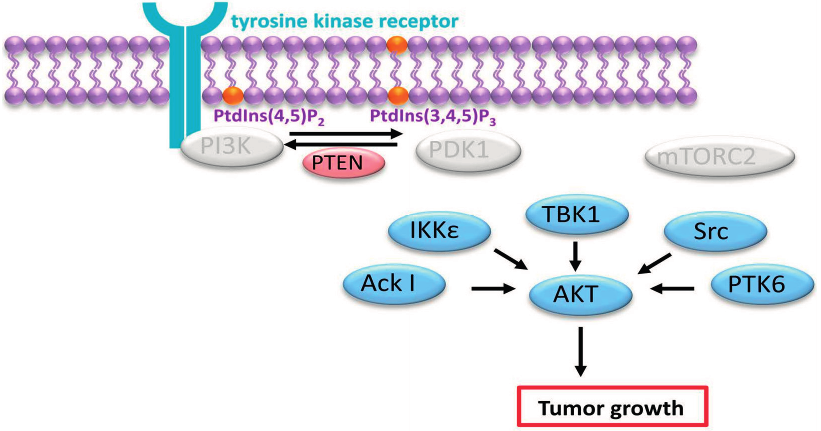
Figure 4. PI3K-independent AKT activation in cancer. Several kinases including Ack I, IKK ε , TBK1, Src, PTK6 (protein tyrosine kinase 6) can activate AKT independently of PDK1 and mTORC2. Light gray ovals imply components of the signaling pathway that are not activated or